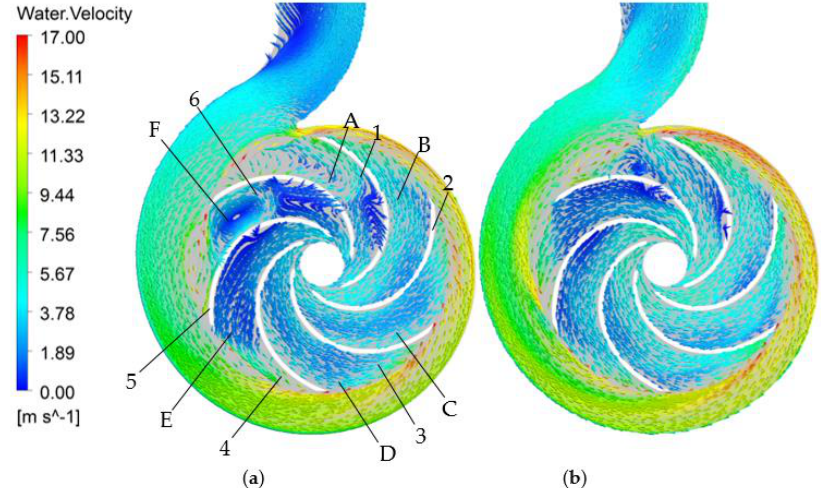
Figure 14. Water velocity distribution in axial plane b at extreme part load conditions. ( a ) 0.2 Q d , ( b ) 0.4 Q d .